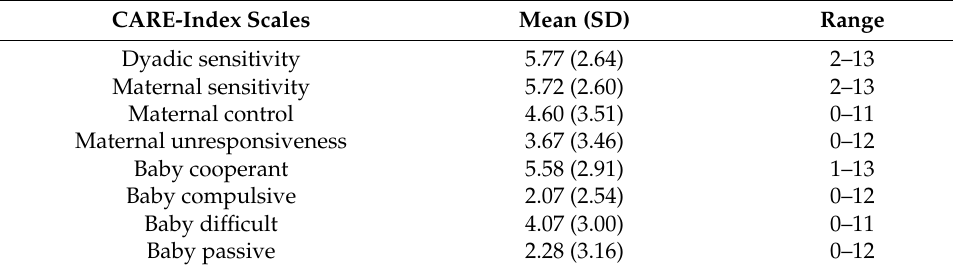
Table 4. Descriptive statistics of CARE-Index scales (N =